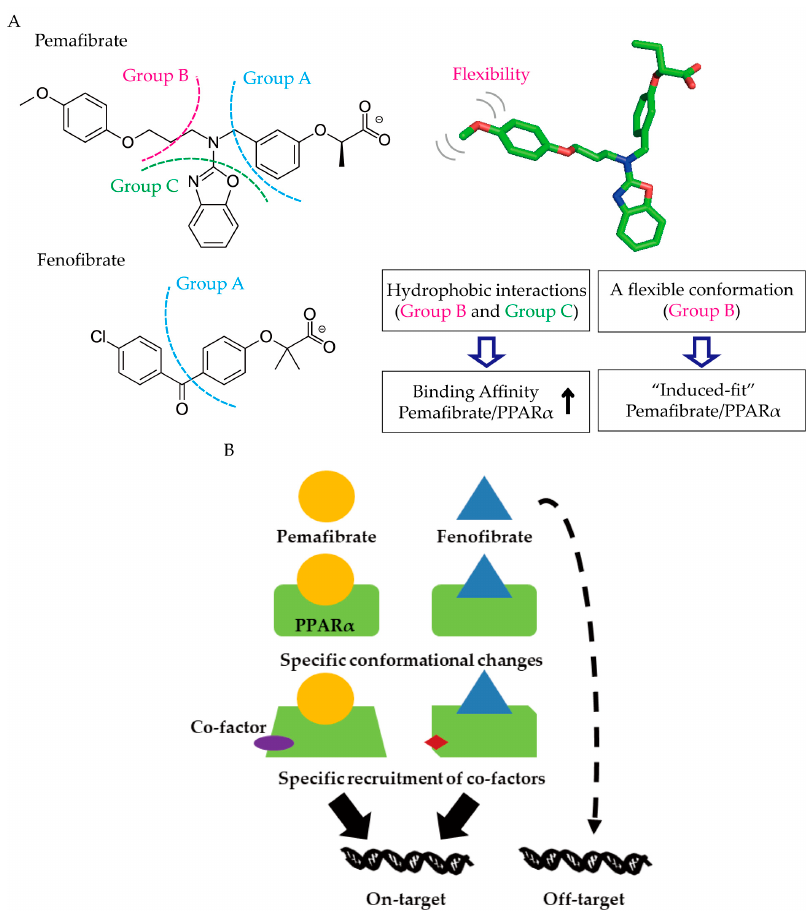
Figure 2. Structural differences between pemafibrate and fenofibrate. ( A ) The structure of pemafibrate contains the carboxylic acid group (Group A, blue color), phenoxy alkyl group (Group B, red color) and 2-aminobenzoxasole group (Group C, green color) while that of fenofibrate only contains Group A. This hydrophobic Y-structure of pemafibrate (Group B and C), which interacts with the hydrophobic residues in the ligand-binding pocket of PPAR α , results in the improvement of fitting with the ligand-binding pocket of PPAR α via increasing the receptor-ligand binding affinity. The flexibility of Group B confers the stronger “induced fit” conformation with PPAR α . ( B ) The specific binding of pemafibrate can induce specific conformational transitions of PPAR α with specific co-factor complexes resulting in exerting the on-target effects of PPAR α activation while that of fenofibrate could exert the on-target as well as off-target effects other than PPAR α activation such as deleterious effects on the renal function including increased serum creatinine levels. Solid lines: a direct series of an event; A dotted line: an indirect series of an event.